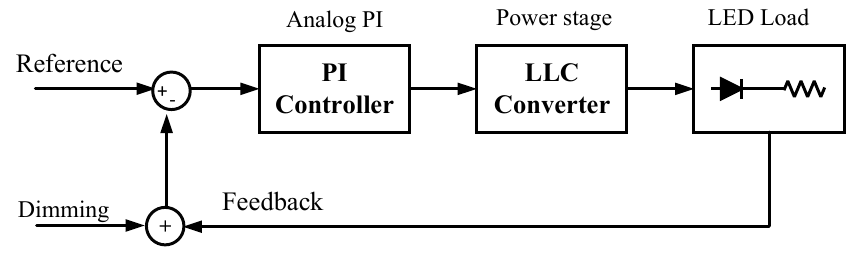
Figure 13. Principle of LED light dimming.